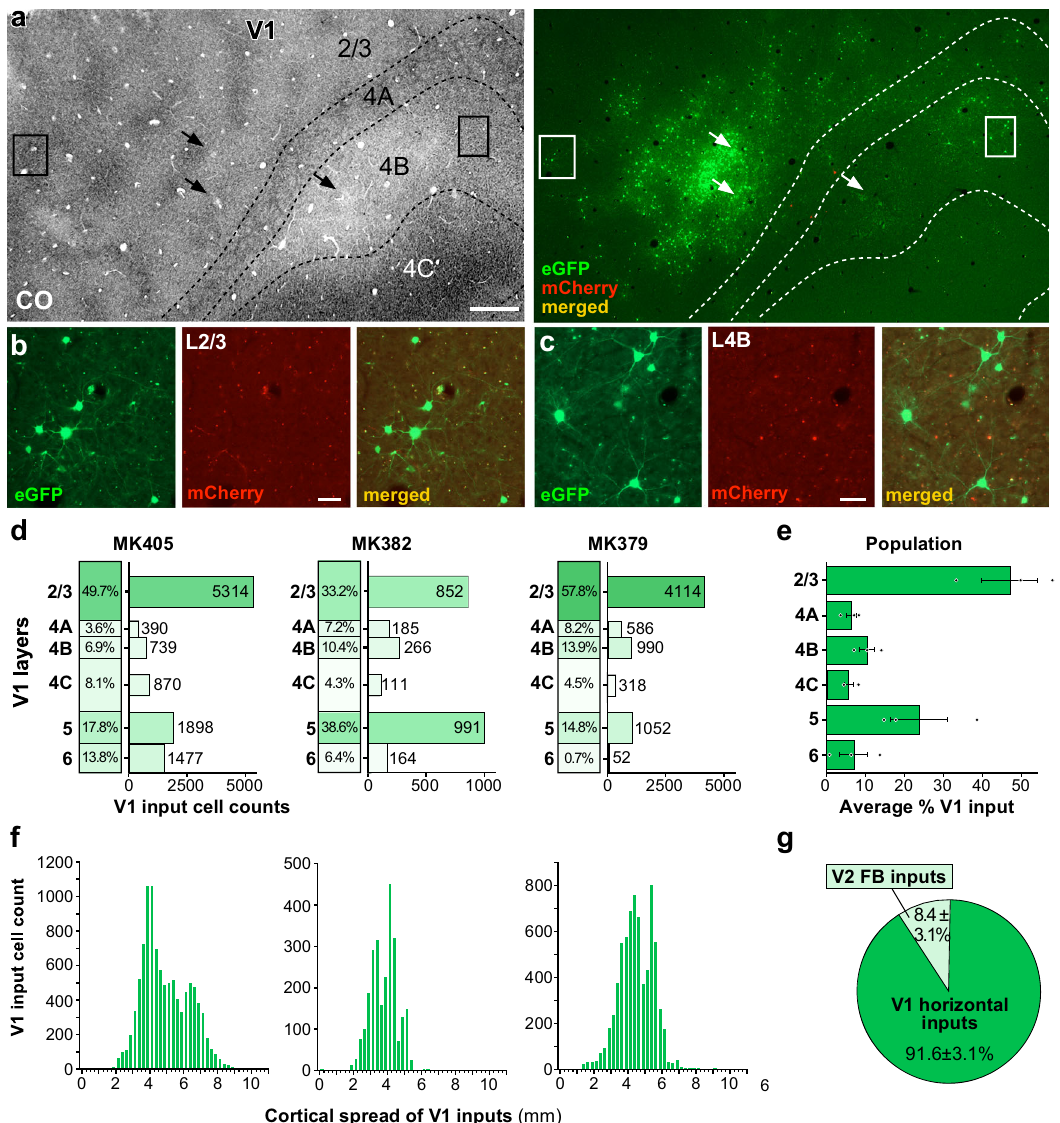
Fig. 7 Laminar and tangential distribution of long-range V1 inputs. a Case MK405. Image of a single tangential section through V1 L2/3 – 4C stained for CO (Left) after being imaged for mCherry and GFP fl uorescence (Right). The merged channel shows plenty of GFP-labeled V1 input cells (green) in L2/3, 4A – 4C away from the injection sites (arrows). The locations of the injection sites were determined in more super fi cial sections where the CO discoloration was more visible than in the indicated section. The region inside the boxes is shown at higher magni fi cation in ( b , c ). Other conventions are as in Fig. 2. Scale bar: 500 µ m. b , c GFP-labeled V1 input cells in L2/3 ( b ) and L4B ( c ), shown under GFP (Left) or mCherry (Middle) fl uorescence, and merged (Right). Scale bars: 50 µ m. Results in ( a – c ) are representative of the V1 GFP label in three independent TRIO experiments. d Percent and number of long-range V1 input cells across layers for each of the three cases. e Average percent ± s.e.m. of V1 input cells across V1 layers for the population. f Tangential spread of V1 input cells for each case (GFP-labeled cells within 400 µ m of each V1 injection site were omitted from the counts). g Average percent of cortical inputs arising from V2 vs. V1 for the population ( n = 20,369 cells in 3 independent animals). Error bars: s.e.m. Results in ( a – c ) are representative of injection sites made in three independent cases with similar